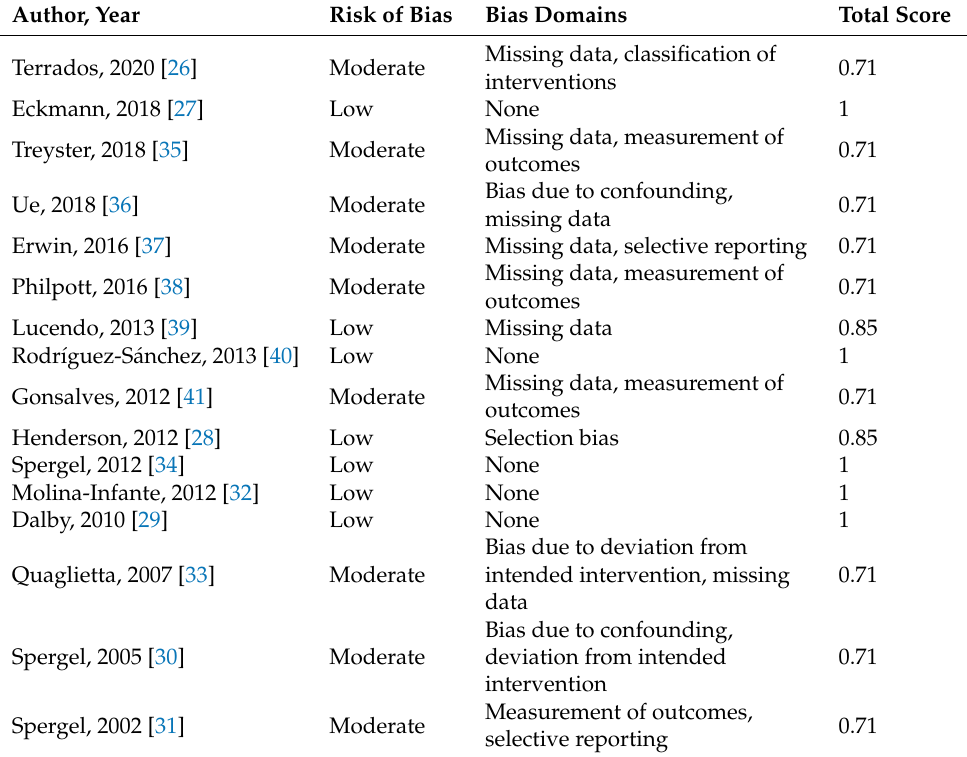
Table 2. Quality assessment of the evidence based on ROBINS-I (“risk of bias in non-randomized studies of